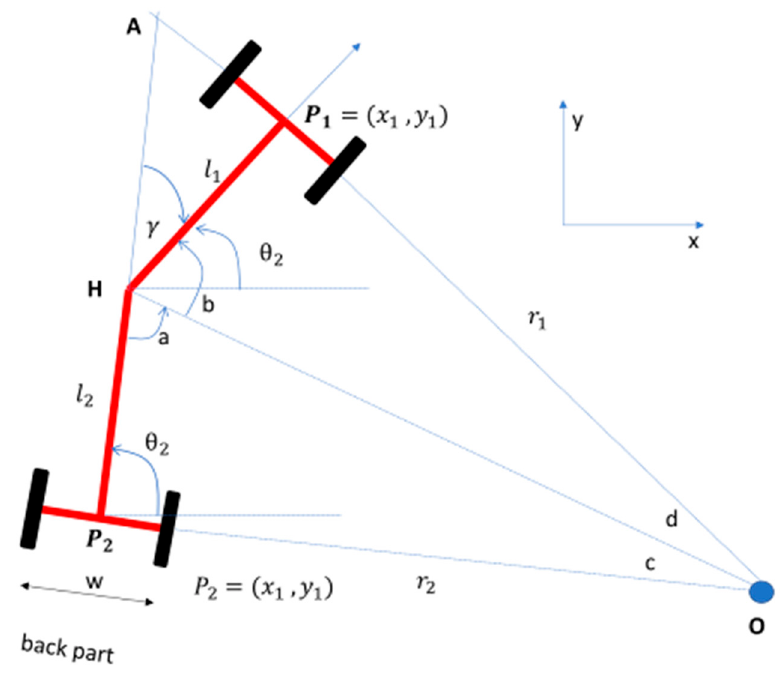
Figure 10. The geometry of the center-articulated rover while turning. r 1 is the distance from the origin of the turning circle O [45].